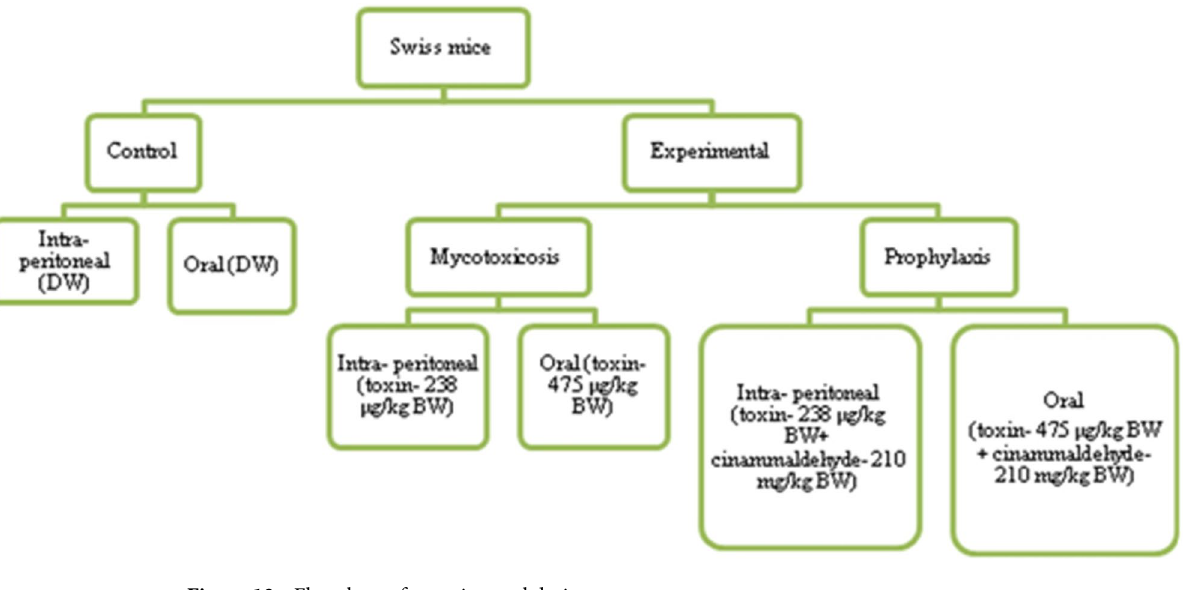
Figure 12. Flowchart of experimental